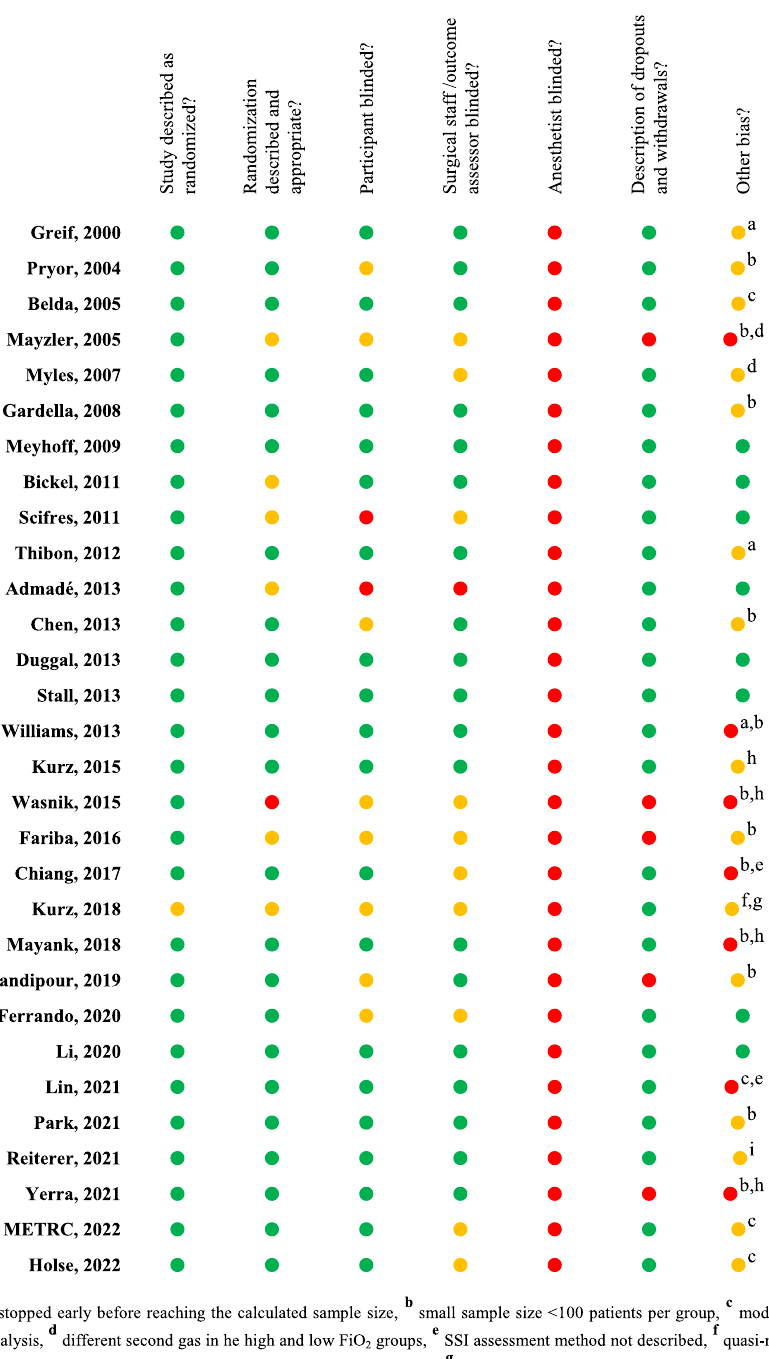
Figure 2. Risk of bias summary for the 30 studies included in the meta-analysis. Green circles represent low risk of bias, yellow circles represent unclear of moderate risk of bias, and red circles represent high risk of